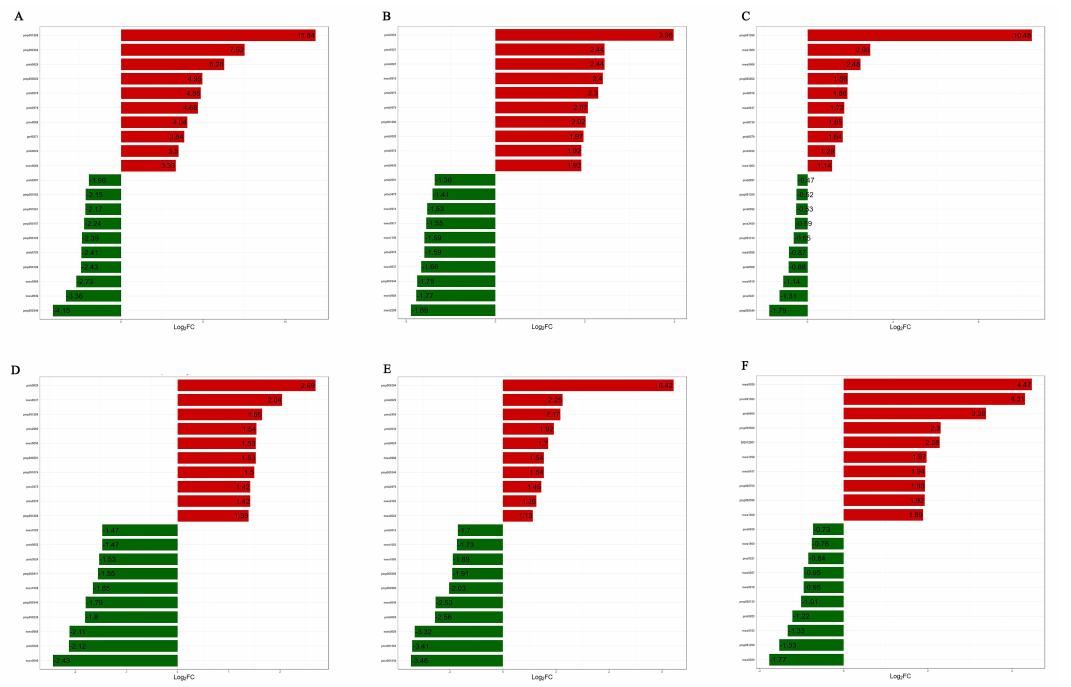
Figure 7. Fold change diagrams of flavonoid differential metabolites in each comparison group. ( A – F ) represent the differential fold diagrams of flavonoid differential metabolites of A1 vs. A6, A1 vs. A2, A2 vs. A3, A3 vs. A4, A4 vs. A5, and A5 vs. A6, respectively. The abscissa indicates that the different multiples are logarithm values based on 2 and the ordinate indicates the number of flavonoid differential metabolites.